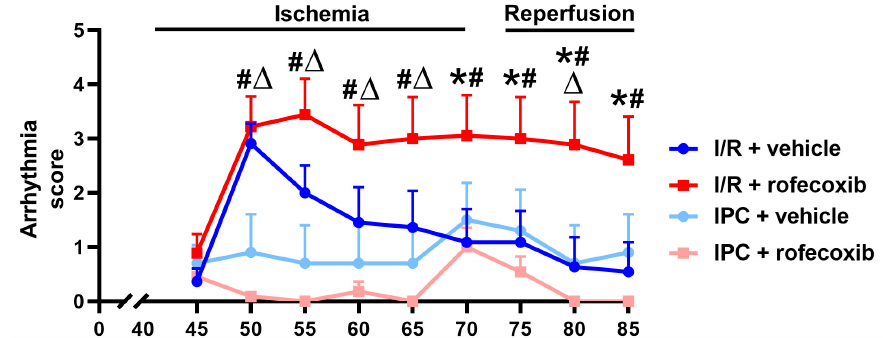
Figure 6. Arrhythmia scores declined gradually starting from the 50 th min. in the I / R + vehicle (ischemia / reperfusion) group but remained elevated in the I / R + rofecoxib group (* p < 0.05 I / R + vehicle vs. I / R + rofecoxib, n = 11–18). IPC (ischemic preconditioning) prevented initial increase of arrhythmia score (# p < 0.05 IPC + rofecoxib vs. I / R + rofecoxib, ∆ p < 0.05 IPC + vehicle vs. I / R + rofecoxib, n = 10–11).